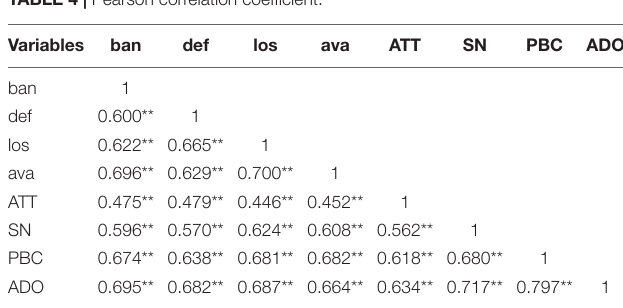
TABLE 4 | Pearson correlation coefficient.